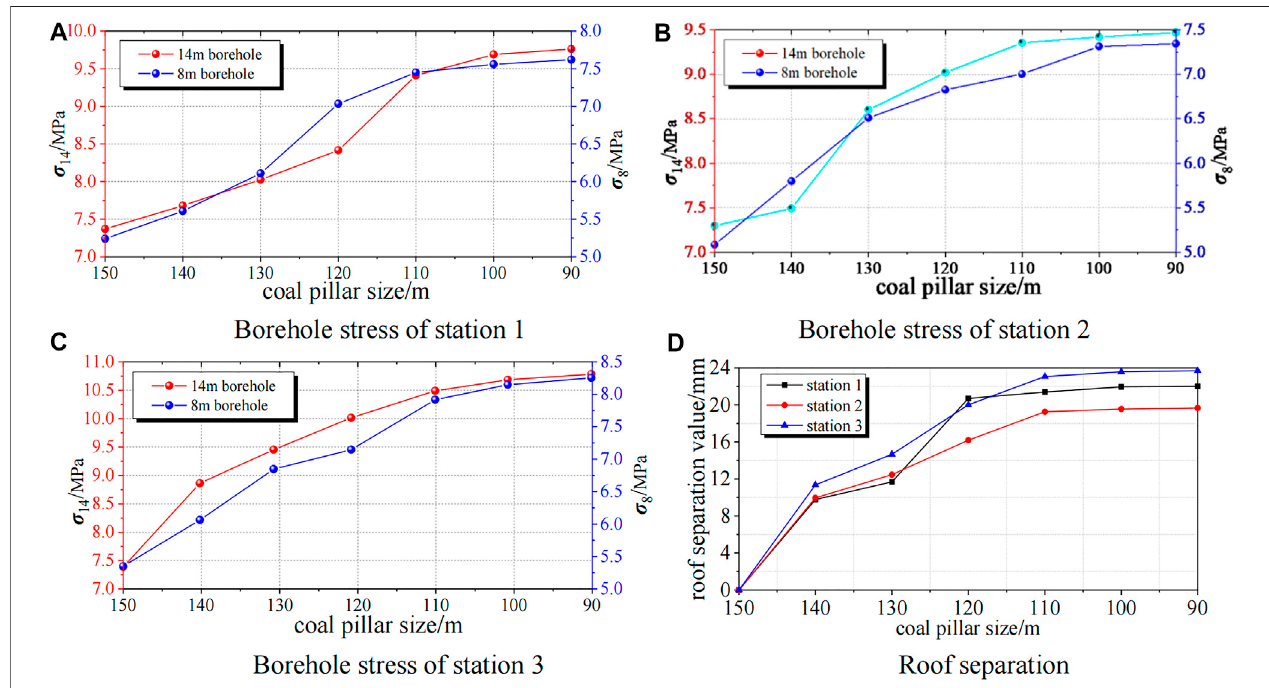
FIGURE 14 | Monitoring results. (A) Borehole stress monitored by three stations; (B) Roof separation monitored by three stations.